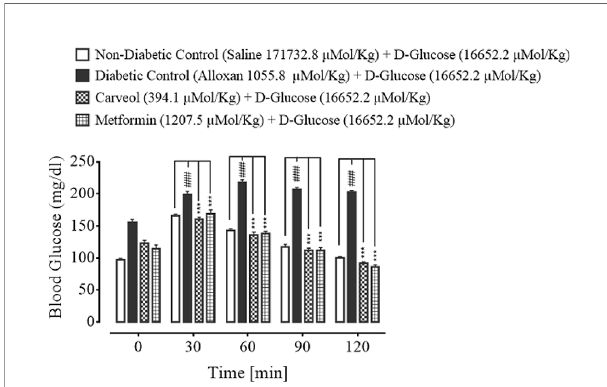
FIGURE 4 | Bar graph representing blood glucose levels at different time intervals (0-120) after administration of oral glucose load (non-diabetic control), alloxan-treated (diabetic control), carveol-treated, and metformin- treated groups. Values expressed as mean ± SEM. One-way ANOVA was used for statistical analysis, followed by post-hoc Tukey ’ s test. ### p < 0.001 vs. saline group and *** p < 0.001 comparison of the blood glucose levels of carveol- and metformin-treated groups vs. diabetic control